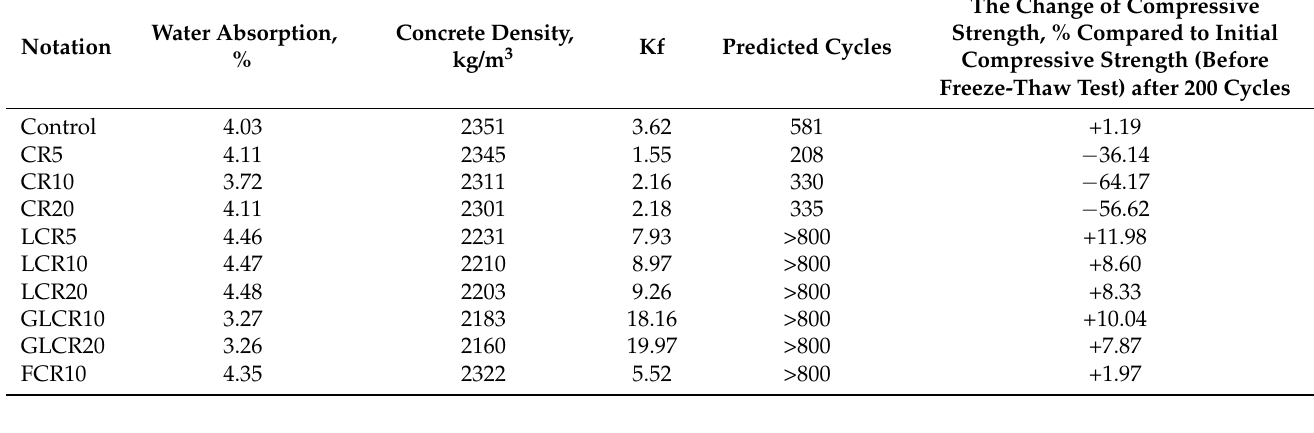
Table 5. Durability parameters of hardened concrete.